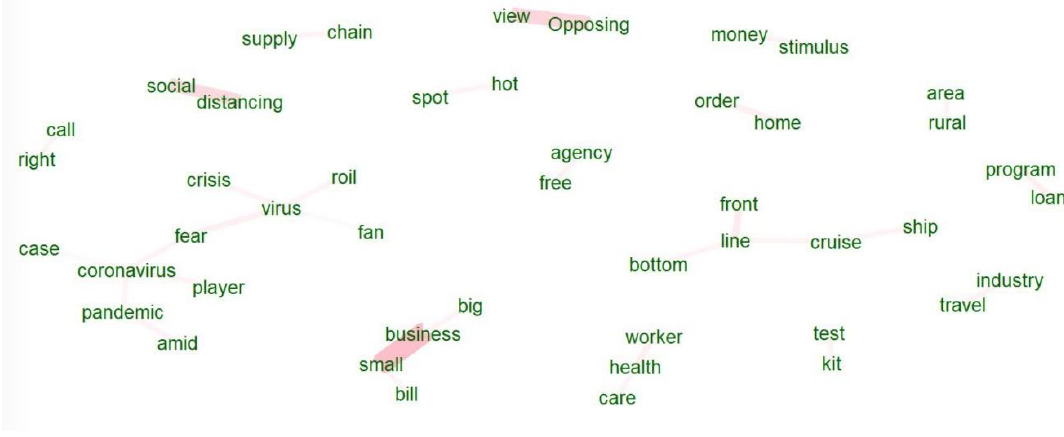
Figure 3. Co-occurrences within three words’ distance: nouns and adjectives (USA Today).